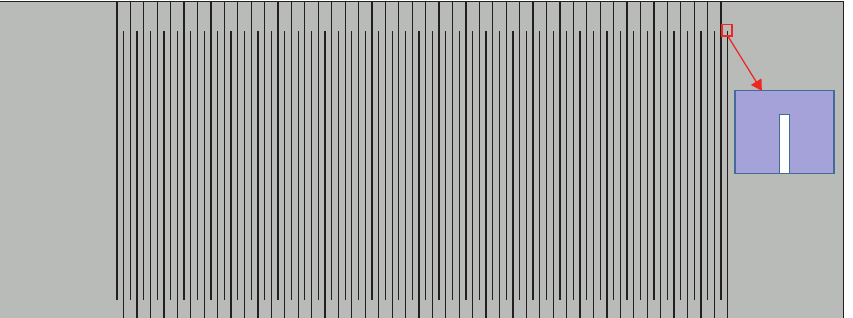
Figure 1: Gas drainage model of borehole across strata.